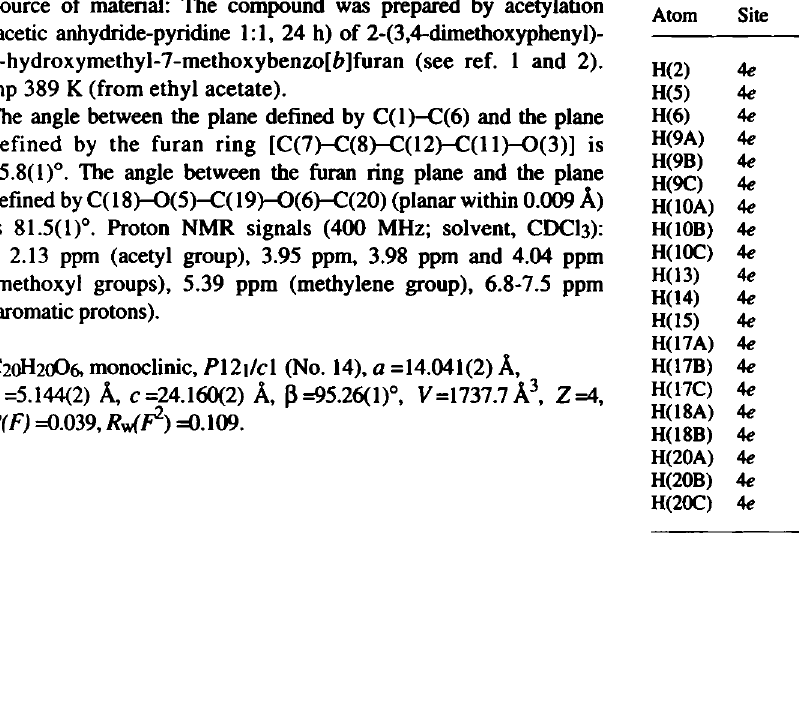
Table 2. Final atomic coordinates and displacement parameters (in Â 2